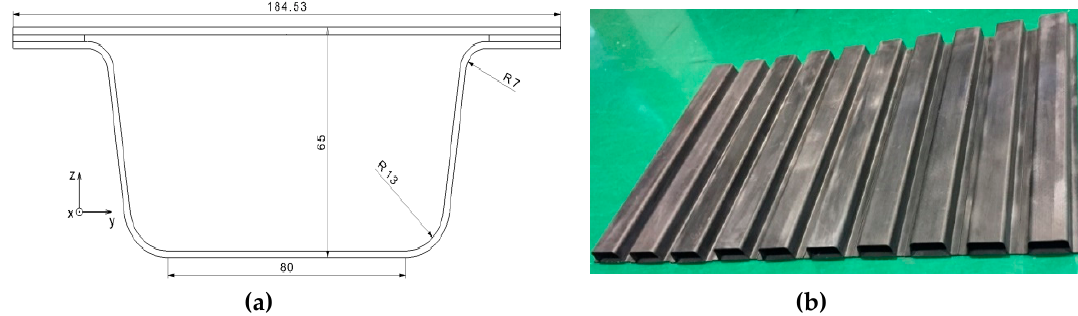
Figure 2. Rocker panel component in carbon fiber. ( a ) Cross section of the rocker panel. ( b ) Test specimens.